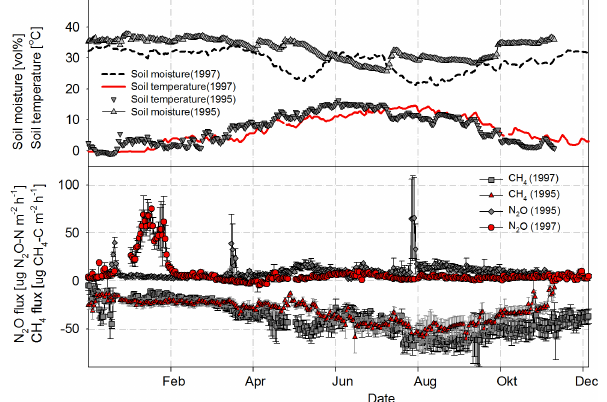
Fig. 3. Seasonal variability of daily average soil volumetric water content (at 10cm depth) and soil temperature (at 10cm depth) as well as of soil nitrous oxide and methane fluxes at the tropical forest site Bellenden Ker, Queensland, Australia, for the period 2 Novem- ber 2001 to 31 October 2002.